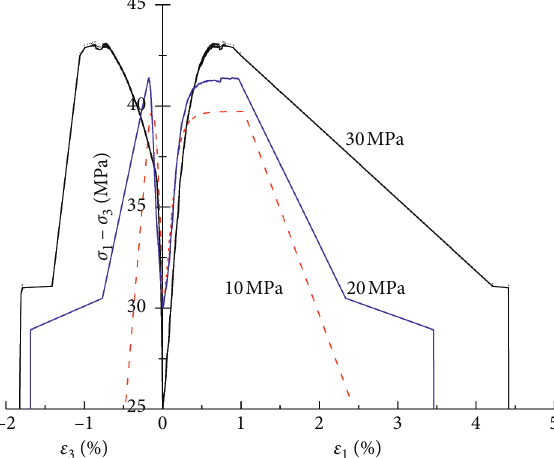
Figure 8: Lateral unloading stress-strain curves of frozen sandstone under different confining pressures ( − 10 ° C, V u �